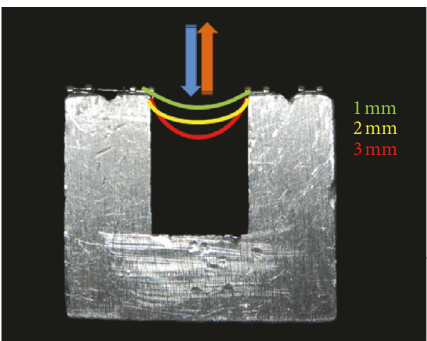
Figure 1: Four passive bicuspid Damon Q self-ligating brackets (Ormco Co., Orange, California, 92867, USA) were attached to the metal base, for the three-point